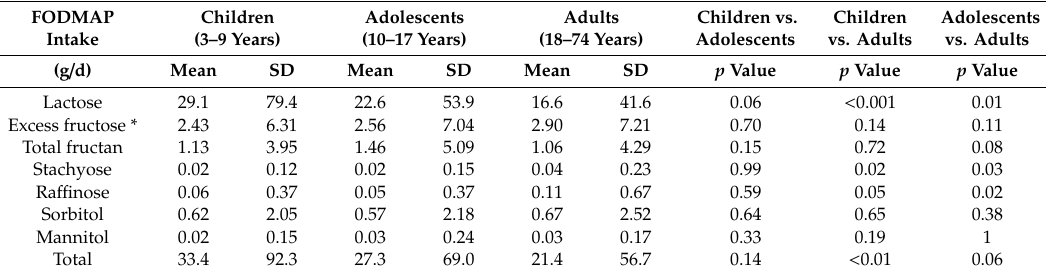
Table 1. Intake of lactose, excess fructose, total fructan, stachyose, ra ffi nose, sorbitol and mannitol in Spanish population stratified by age.